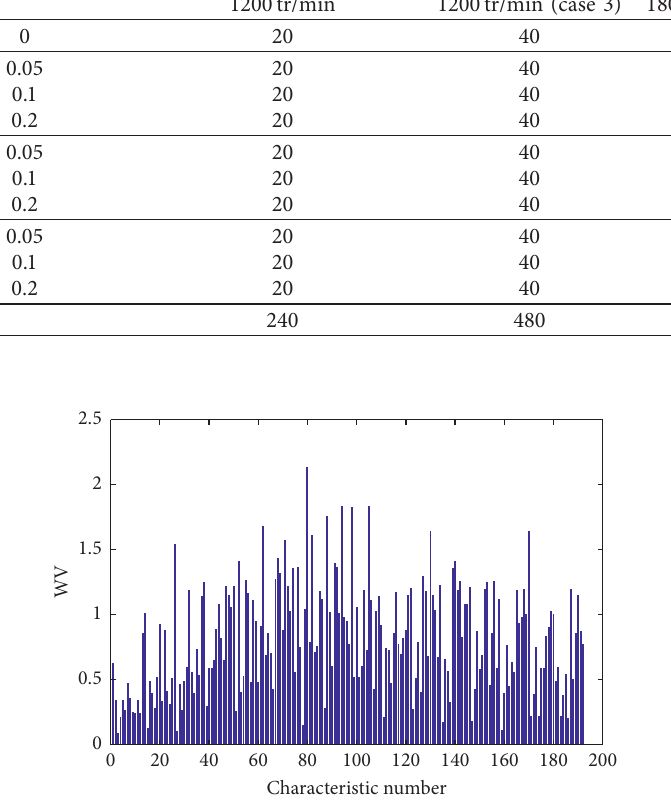
Figure 22: The WV of 192 statistical features of training samples.